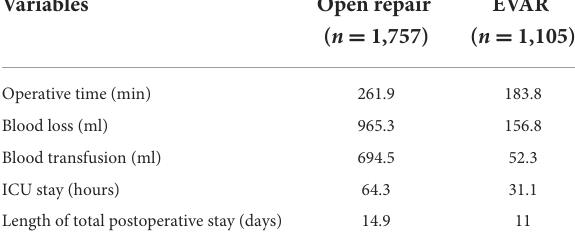
TABLE 5 Perioperative outcomes.